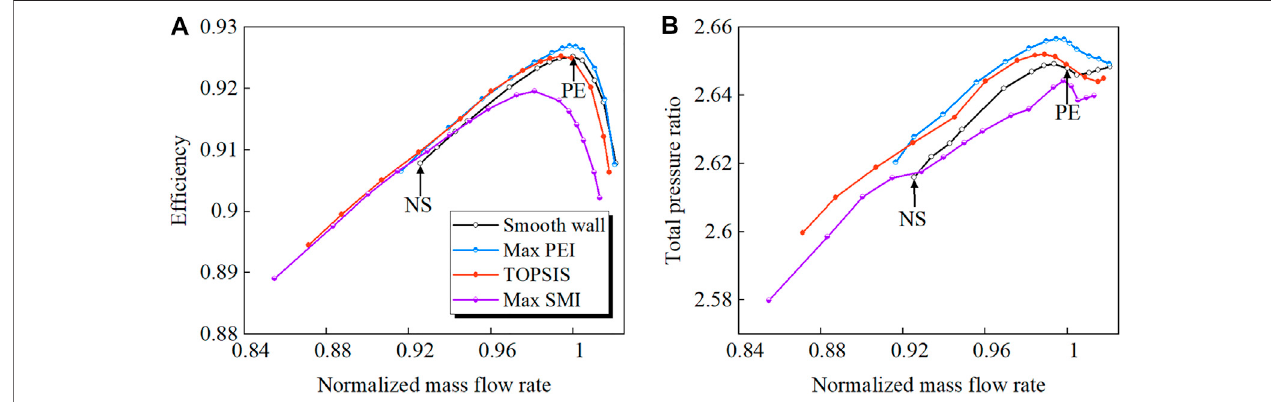
FIGURE 6 | Characteristic lines of rotor with and without casing treatment. (A) Ef fi ciency (B) Total pressure ratio.